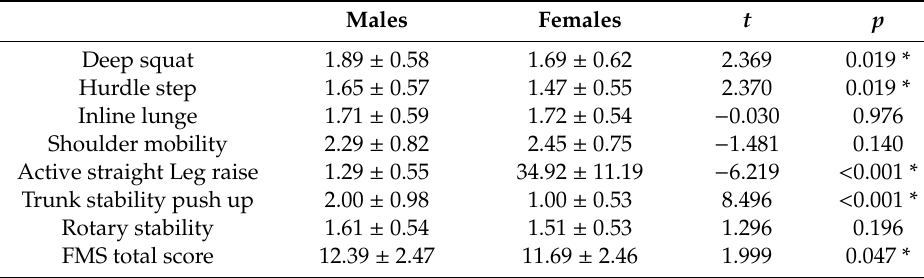
Table 5. Analysis of functional movement screen scores by